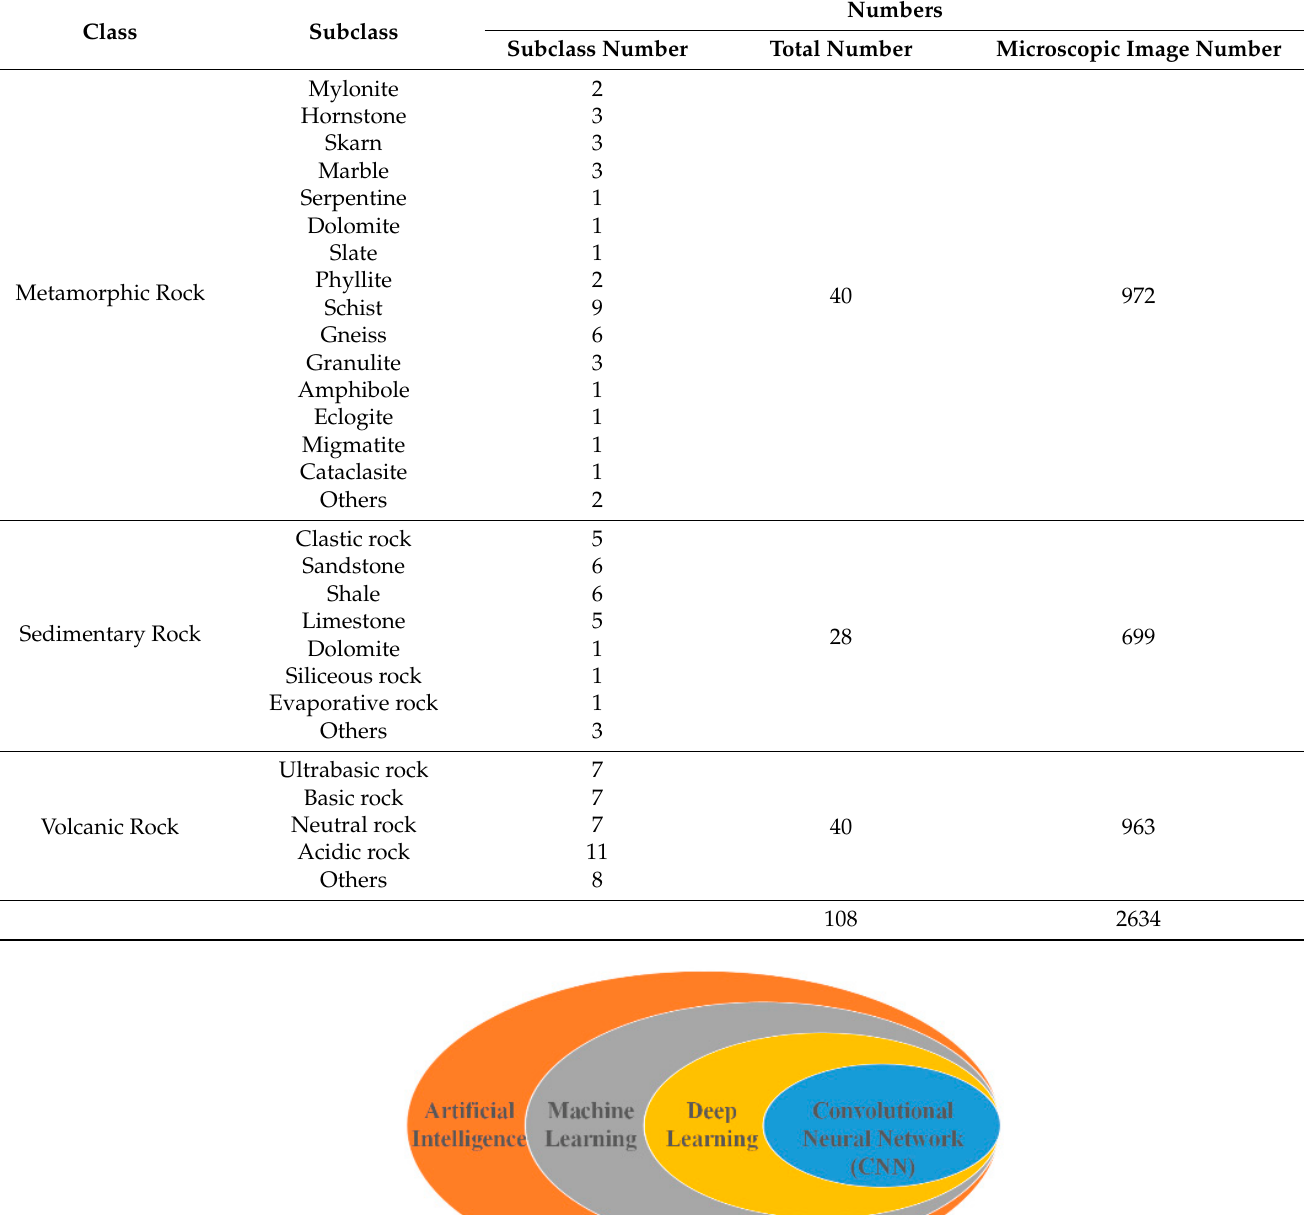
Table 1. Detailed descriptions of the dataset.